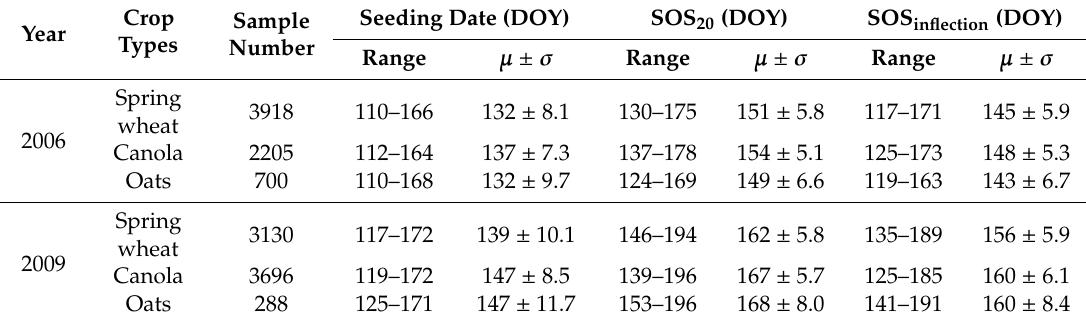
Table 1. Statistical analysis of the observed seeding date and estimated Start-Of-Season; µ and σ are the mean and the standard deviation of the samples, respectively; DOY is the day of year.